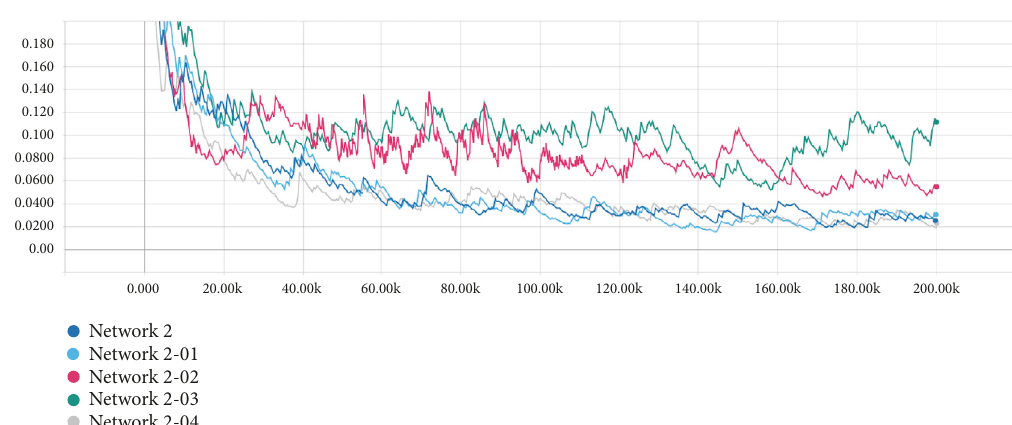
Figure 5: Sensitivity analysis based on data from Network 2.